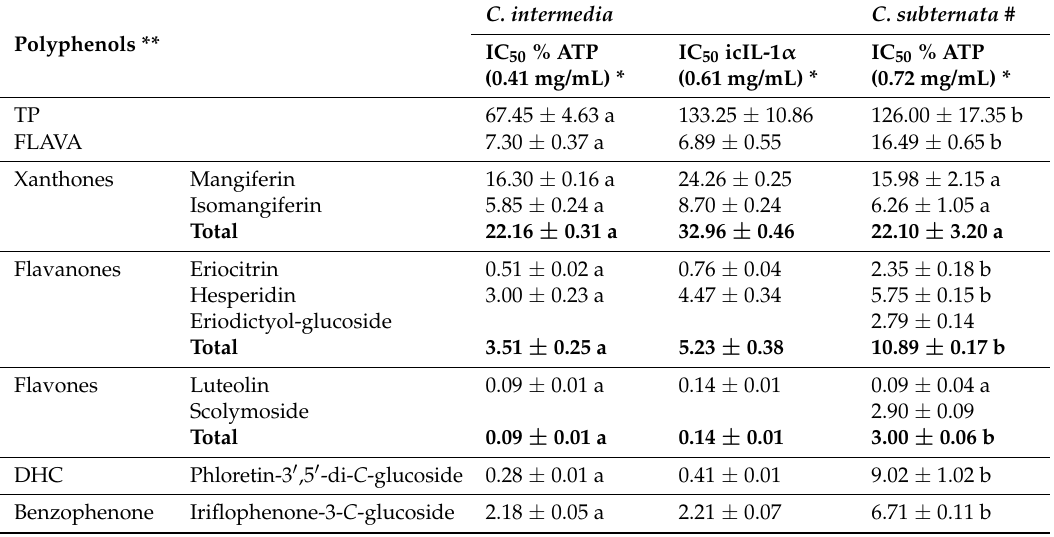
Table 7. Polyphenol concentration ( µ g/mL) of the aqueous extracts of C. intermedia and C. subternata expressed as a function of the IC 50 values for the reduction of cell viability and icIL-1 α following UVB